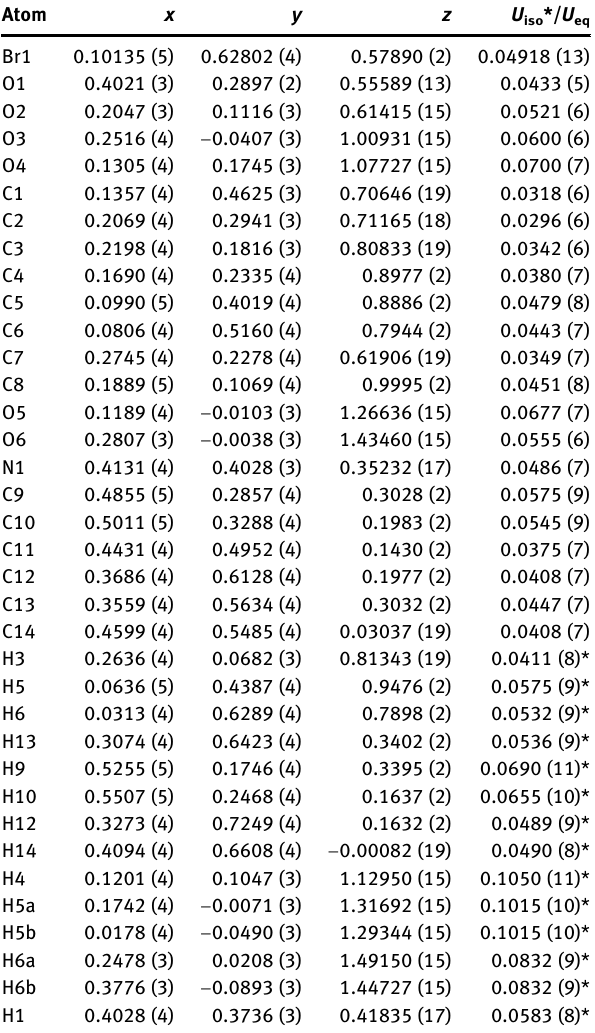
Table  : Fractional atomic coordinates and isotropic or equivalent isotropic displacement parameters (Å  ).